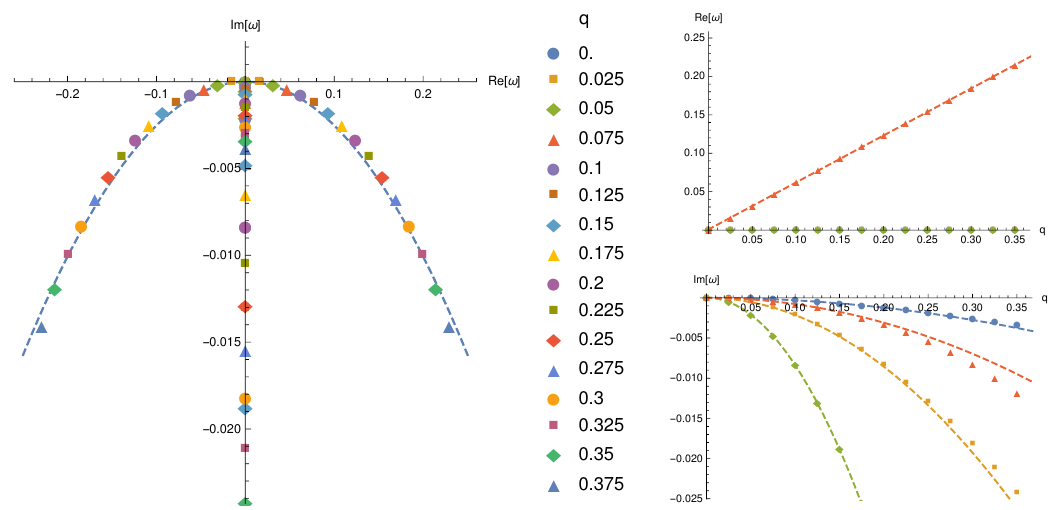
Figure 2 . Quasinormal modes in the purely spontaneously broken phase ( T = 0 : 52 T c ), showing among others the dispersion relation of the Goldstone mode (red dots on the right panel) as a function of momentum q . Left panel: trajectories of QNMs in the complex plane, Right panel: dependence of the real and imaginary parts on